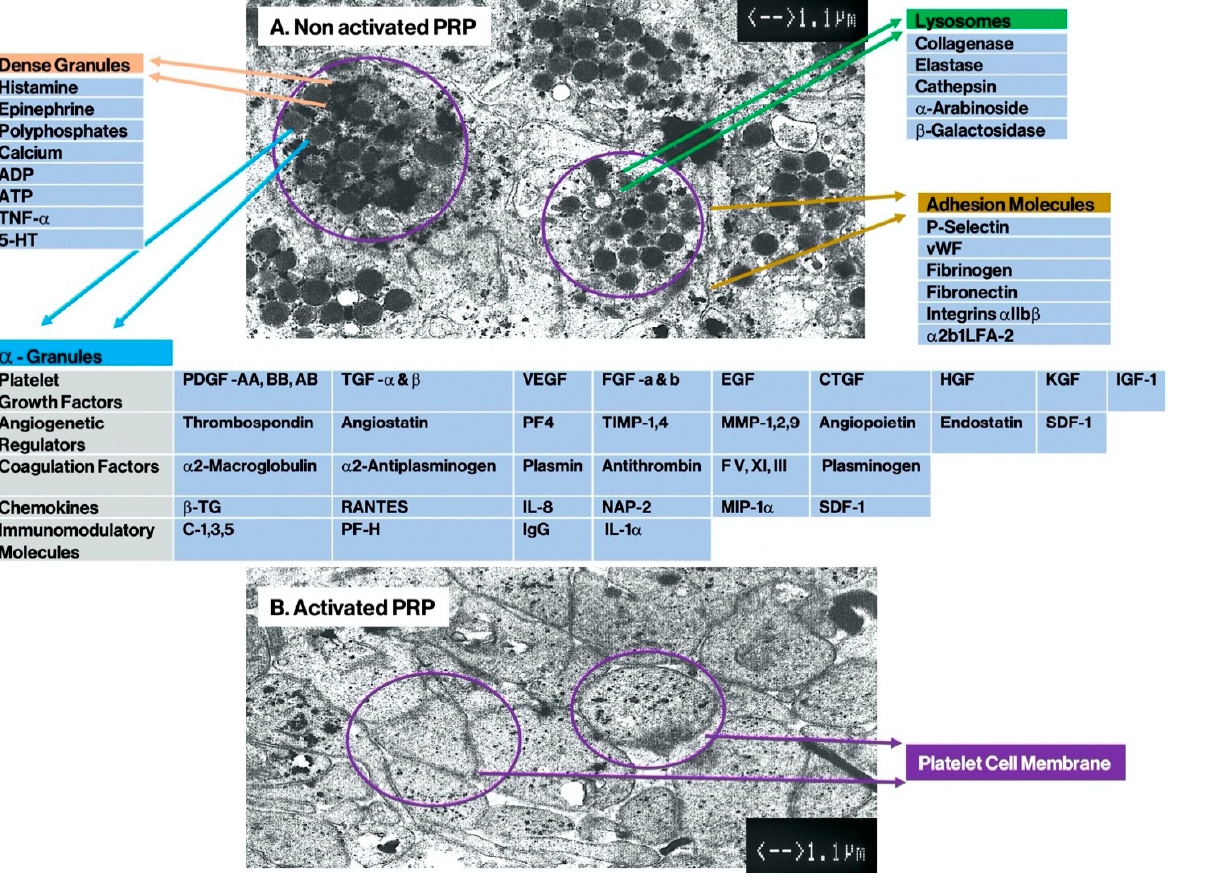
Figure 1. Platelet granular storages and their content in non-activated platelets. Electron microscopic scanning pictures of a cluster of platelets, at original magnification ×10,000. In ( A ), non-activated platelets from a PRP vial (PE) are shown. The ill-defined grey bodies represent the α -granules, approximately 50-80/platelet. The opaque round bodies are the dense granules, ranging from 0–30/platelet, and grey string-like bodies are lysosomes [24]. Thin lines signify platelet cell membranes. In ( B ), disrupted cell membranes are visible as activated platelets have released their granular